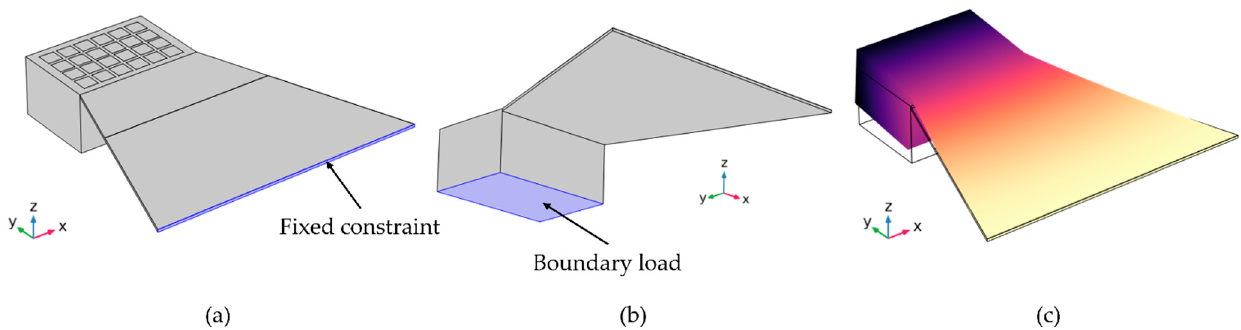
Figure 15. ( a ) Fixed constraint and ( b ) boundary load conditions applied to the geometries. ( c ) First deformation mode of the design 1 harvester.